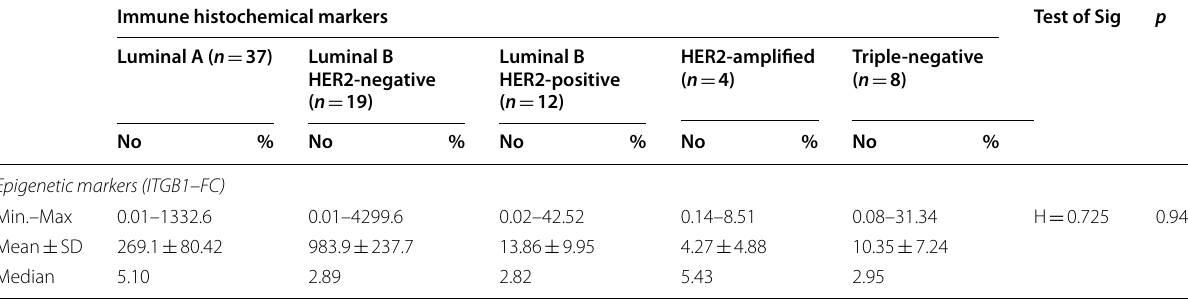
Table 9 Correlation between epigenetic marker expression and molecular subtypes Immune histochemical